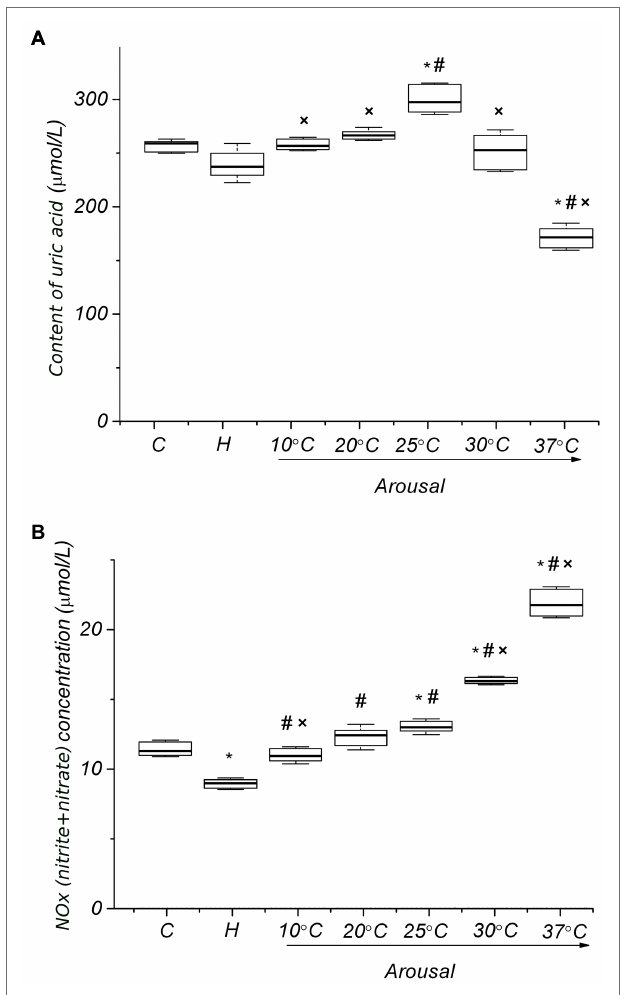
FIGURE 3 | Plasma levels of uric acid (A) and NOx (B) of ground squirrels during arousal from hibernation. C, control; H, hibernation; and body temperature ( ° C; n = 6). Data are presented as box plots that show the median, 25/75 percentiles (box), and 10/90 percentiles (bars). * p < 0.001, compared with C; # p < 0.001, compared with H; × p < 0.001, compared with Tb 25 °